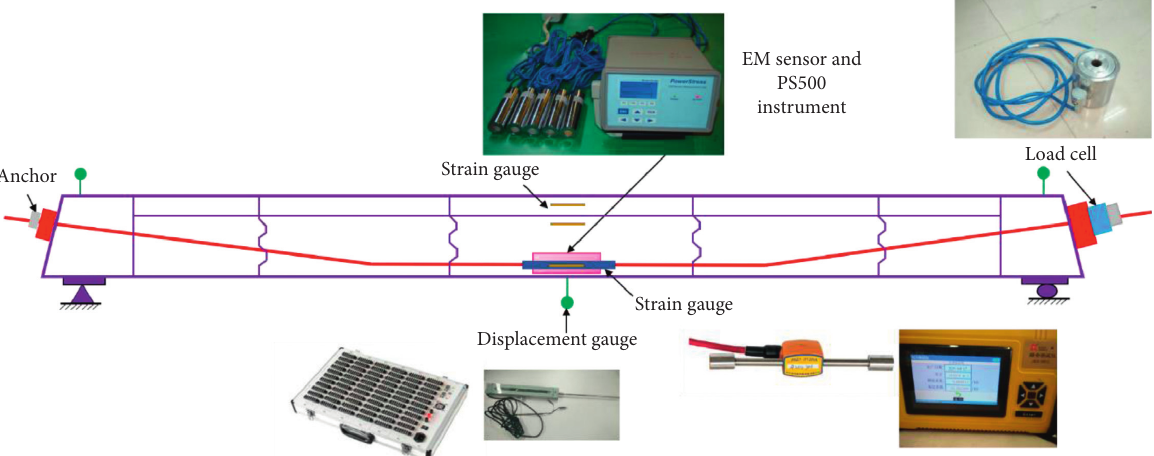
Figure 4: Layout of measuring points.